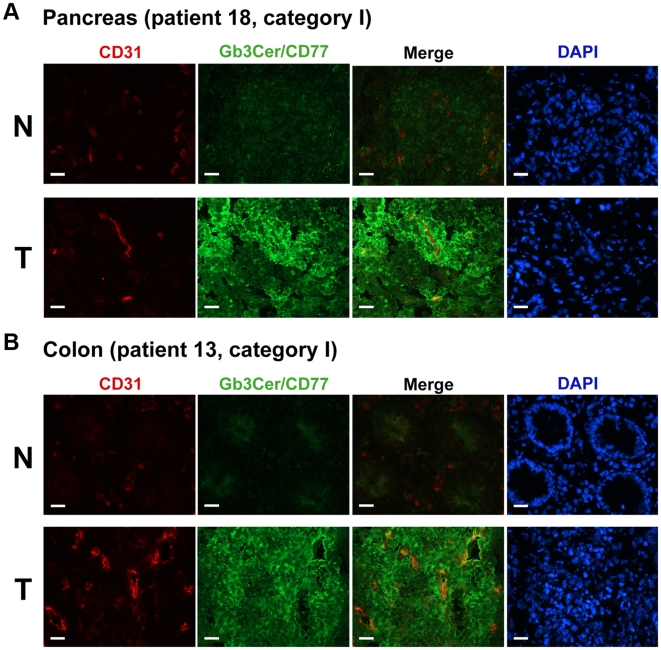
Immunohistological detection of Gb3Cer/CD77 in cryosections of pancreas (A) and colon cancer (B).Sections of normal (N) and tumor tissue (T) of pancreatic cancer patient 18 (A) and of colon cancer patient 13 (B) were immunostained with the anti-Gb3Cer/CD77 antibody and coimmunostained with an antibody against the endothelial cell marker CD31. Cell nuclei were detected with DAPI. Scale bars correspond to 20 µm. Representative examples of tumors of category I are shown (see Table 1). The histopathological data of pancreas and colon carcinoma are summarized in Supplementary Tables S1 and S2, respectively.